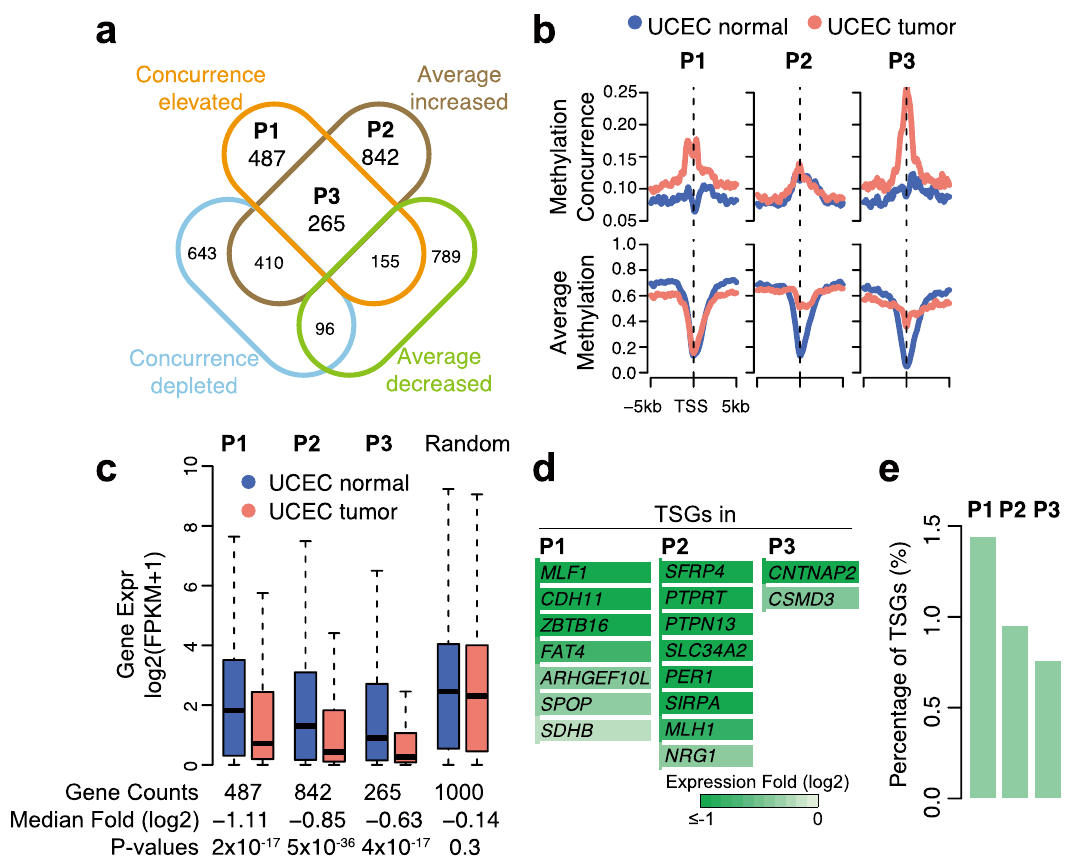
Fig. 3 Tumor repressors can be repressed by methylation concurrence elevation rather than hypermethylation in uterus tumor. a Venn diagram shows the overlap between promoter methylation concurrence altered genes and average methylation altered genes in TCGA uterus tumor (UCEC). P1, methylation concurrence elevated but average methylation stable genes; P2, hypermethylated but concurrence-stable genes; P3, concurrence-elevated and hypermethylated genes. b Average pro fi les of methylation concurrence (upper panel) and average methylation (lower panel) in TSS regions of P1, P2, and P3 genes. UCEC normal is in blue, and UCEC tumor is in red. c Gene expression change of P1, P2, P3, and 1000 randomly selected genes. The fold changes between median values (log2 scale) are indicated below. The two-tailed Wilcoxon signed-rank test was used for the signi fi cance test. The line in the box center refers to the median, the limits of box refer to the 25th and 75th percentiles and whiskers are plotted at the highest and lowest points within the 1.5 times interquartile range. The lists of repressed genes in three groups are in Supplementary Data 2. d COSMIC tumor suppressor genes which are overlapped with P1, P2, and P3 genes. Gene expression fold changes (log2 scale) are indicated. Darker green signi fi es higher repression in the UCEC tumor sample. e The percentages of tumor suppressors in P1, P2, and P3